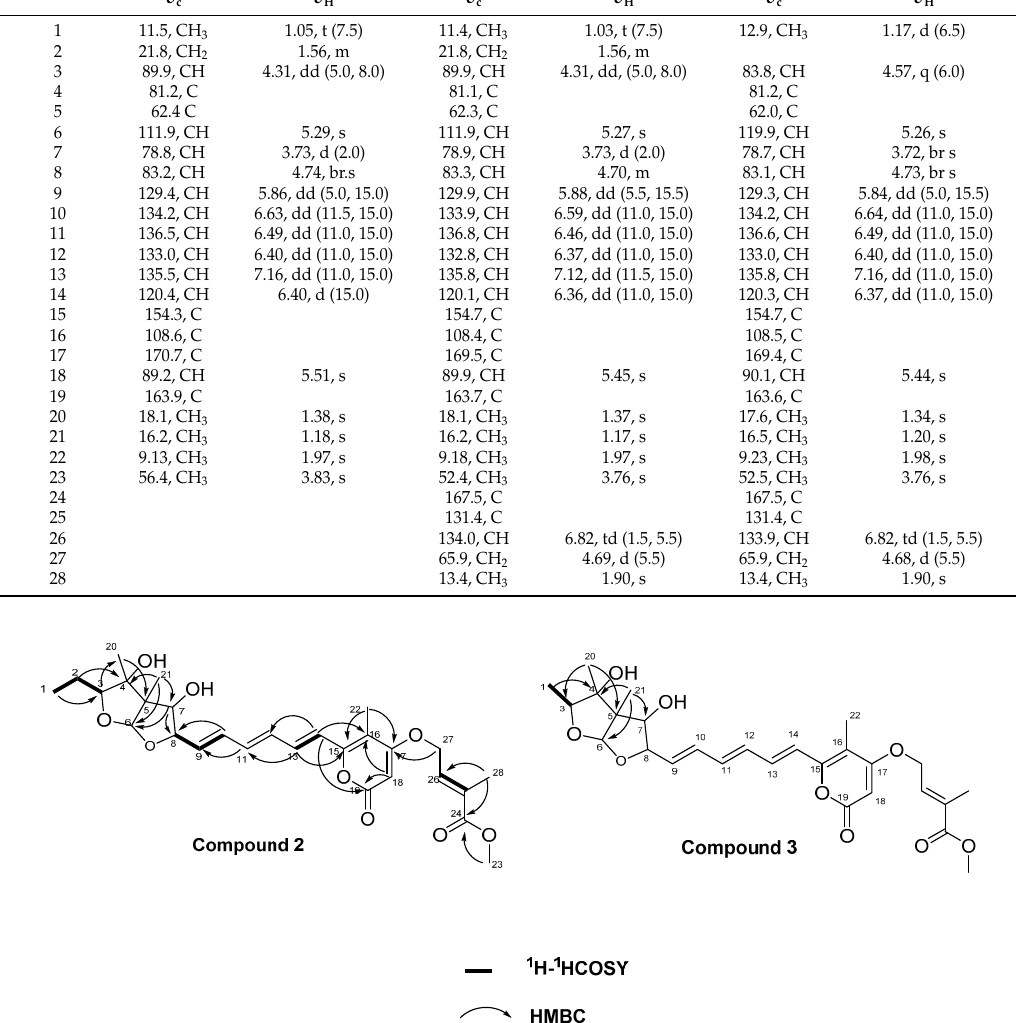
Figure 2. Selected 1 H- 1 H COSY and HMBC correlations of 2 and 3 .